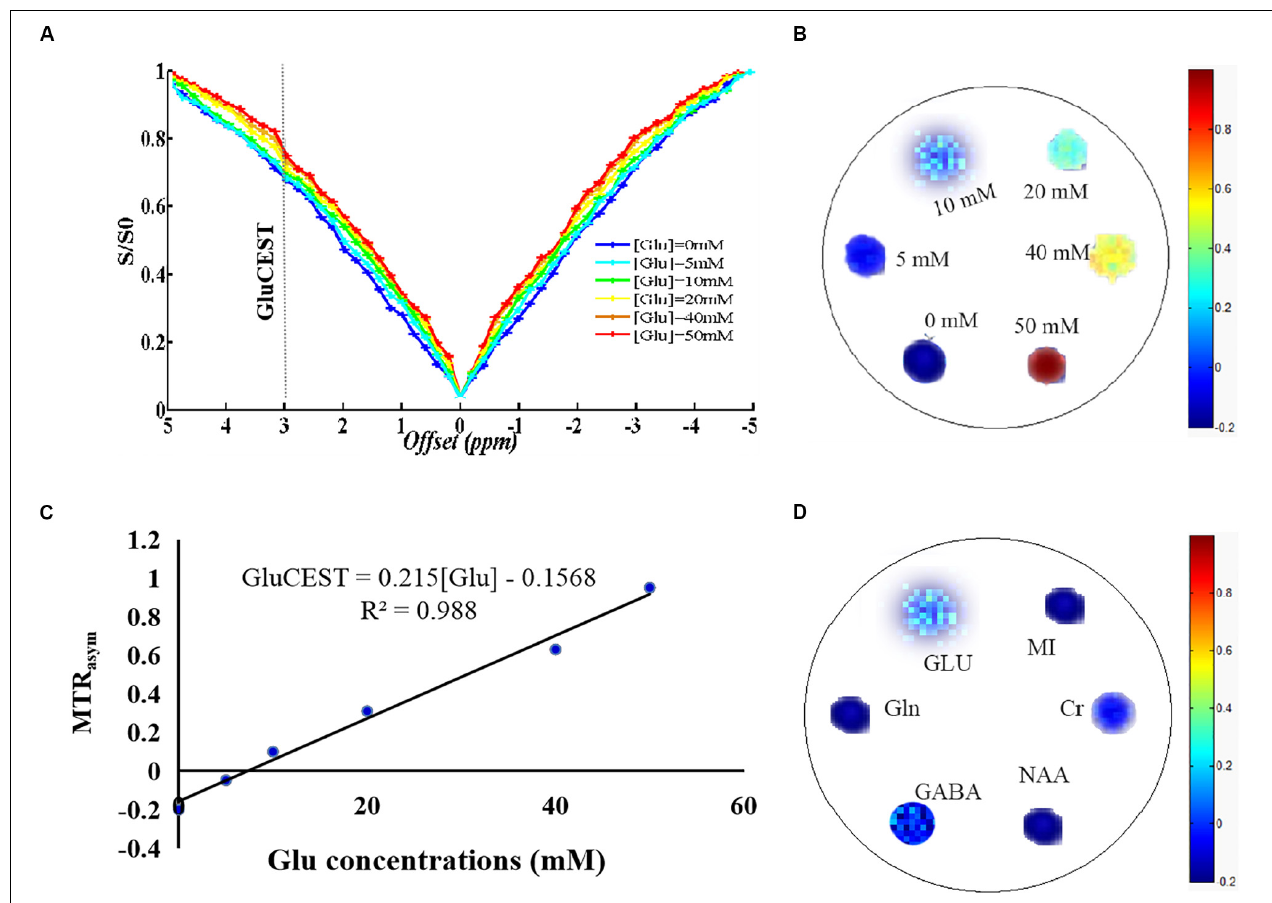
FIGURE 1 | Phantom studies performed on 7.0 T scanner. (A) Z-spectra show that the amine protons on glutamate (Glu) generated a chemical exchange saturation transfer (CEST) effect with a chemical shift of 3.0 ppm away from bulk water. (B) GluCEST map showing that the GluCEST signal was concentration-dependent. (C) GluCEST signal increased as the Glu concentrations increase, which appears to have a good linear relationship, indicating that the GluCEST effect increases by nearly 0.215% with every 1 mM Glu added. (D) Under physiological conditions, Glu is the main contributor to the GluCEST signal and γ -aminobutyric acid (GABA) and creatine (Cr) have a small contribution to the GluCEST effect, while the contribution of other metabolites [ N -acetylaspartate (NAA), myo-inositol (MI), glutamine (Gln)] to the GluCEST effect was negligible.